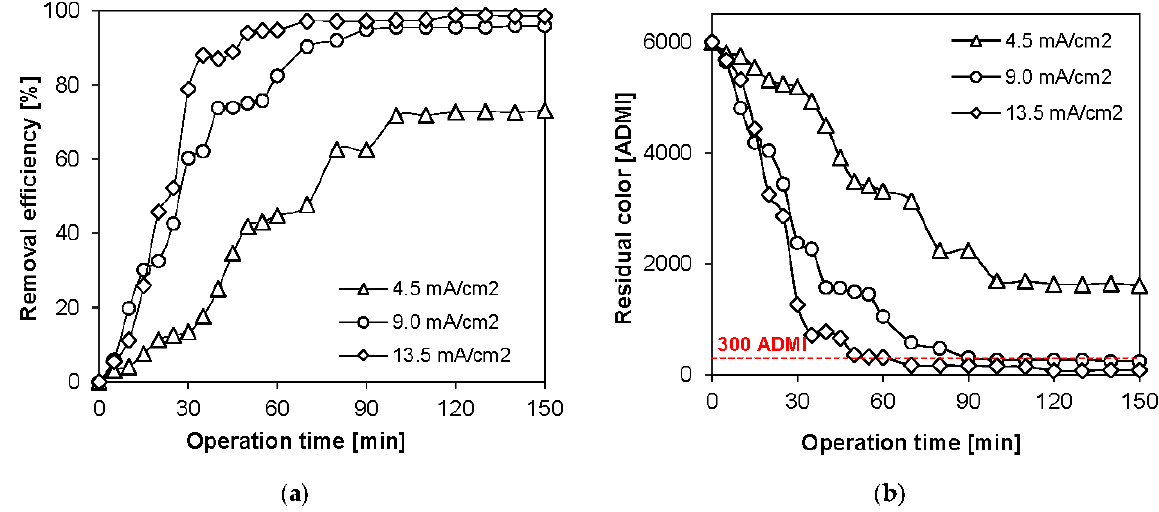
Figure 11. Color removal at different current densities: ( a ) removal efficiency, and ( b ) residual color.